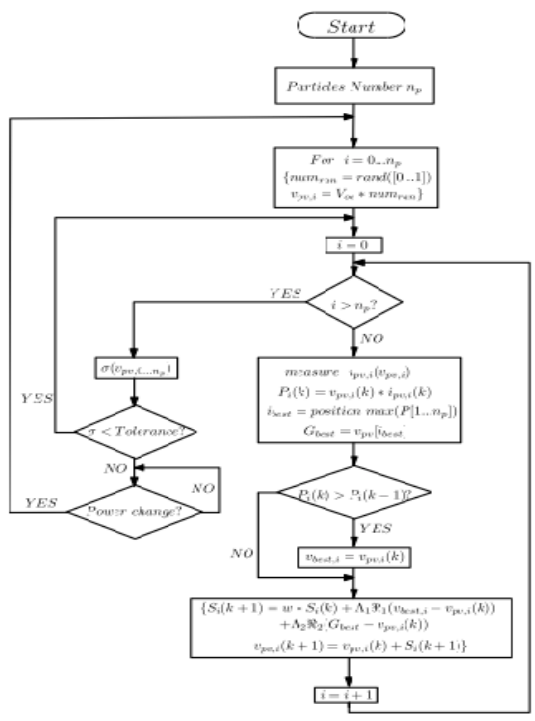
Figure 4. Particle Swarm Optimization (PSO) algorithm.